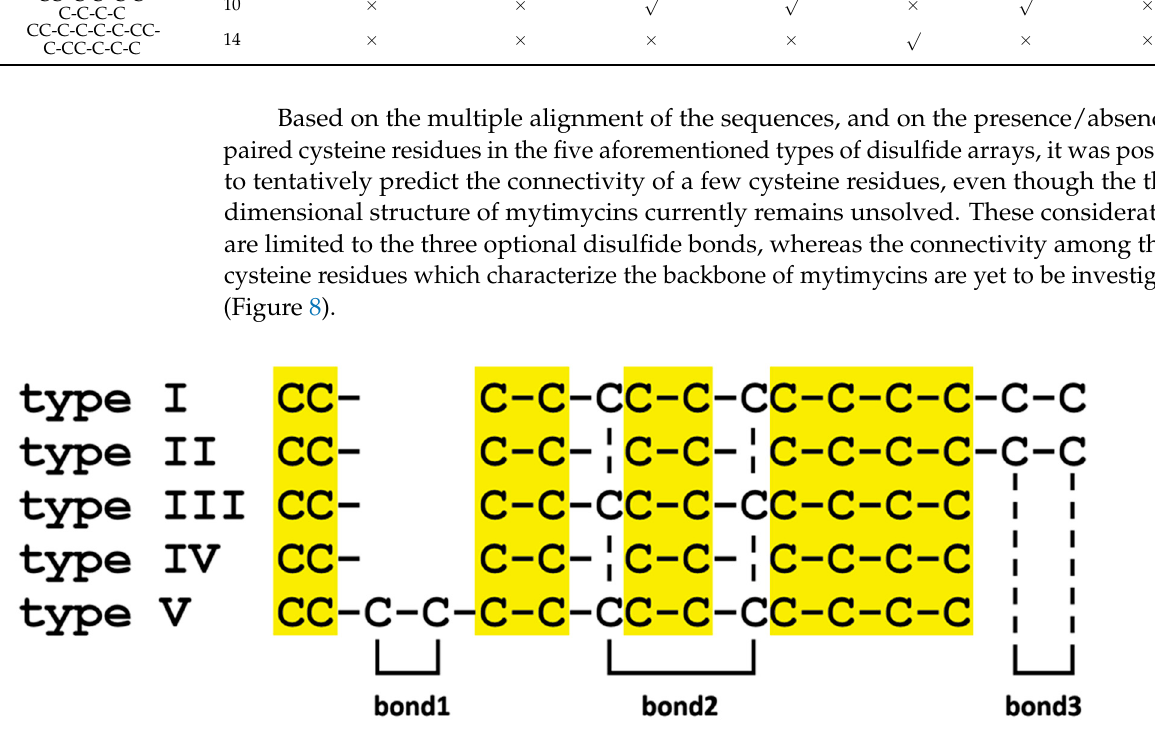
Figure 8. Predicted disulfide connectivity based on in silico analyses. The 10 cysteine residues which compose the backbone of mytimycins are highlighted with a yellow background.